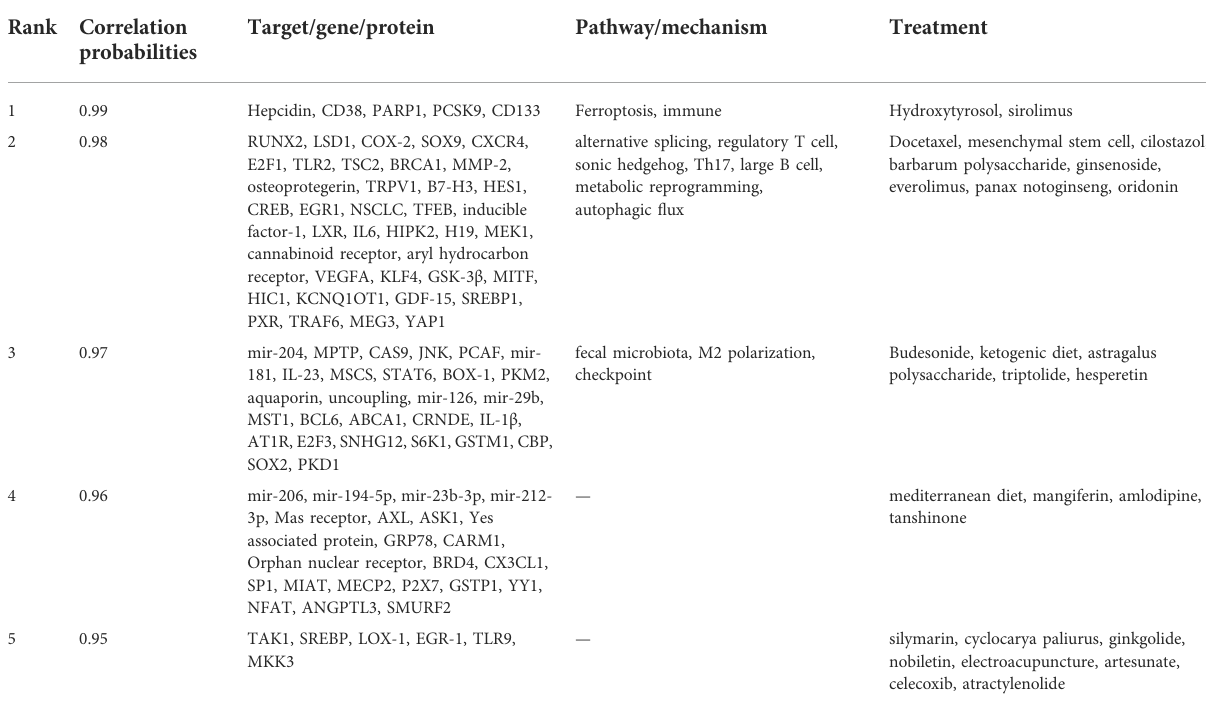
TABLE 6 Potential links between Sirt1 and kidney